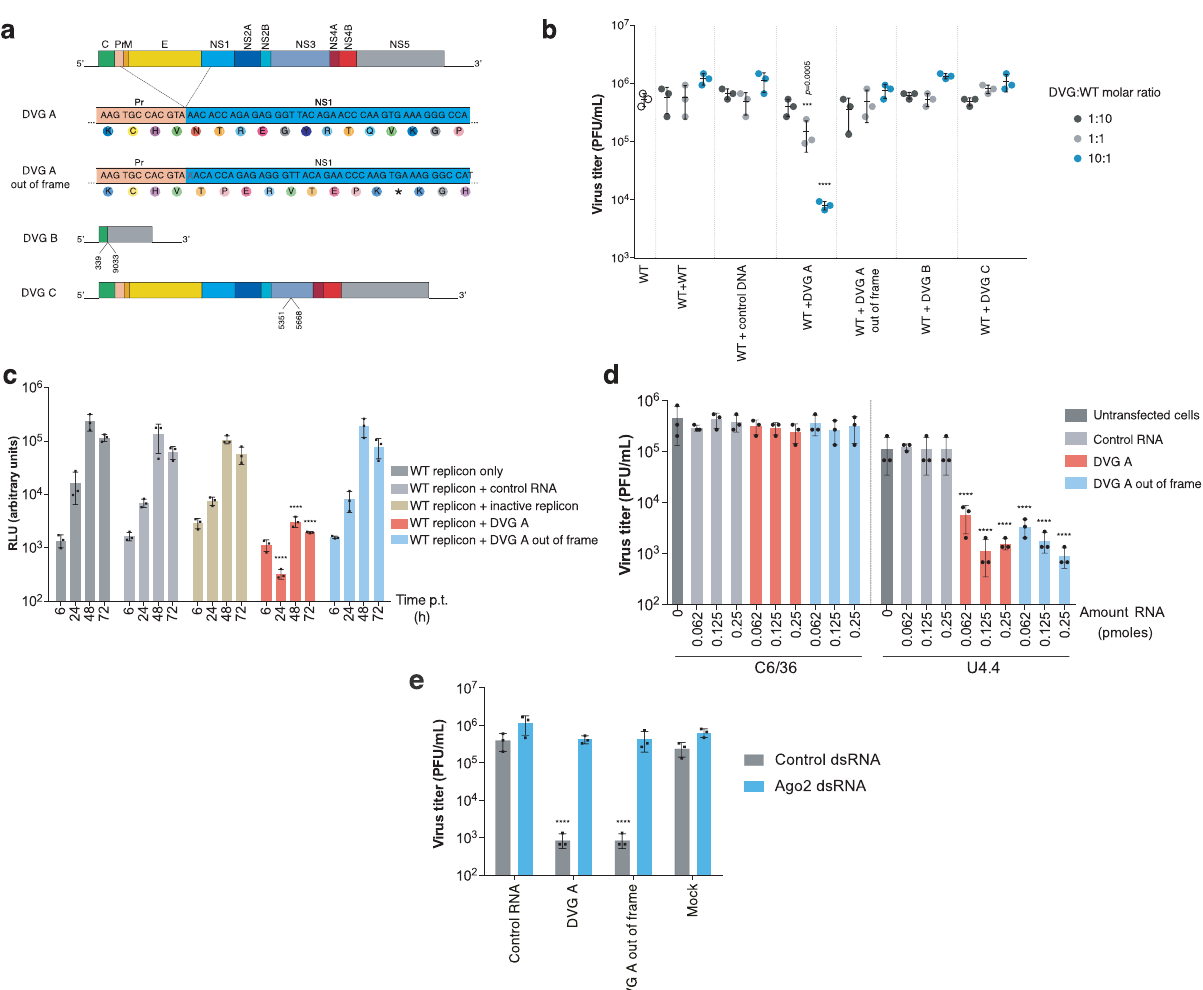
expressing plasmid. Source data are provided as a Source Data fi